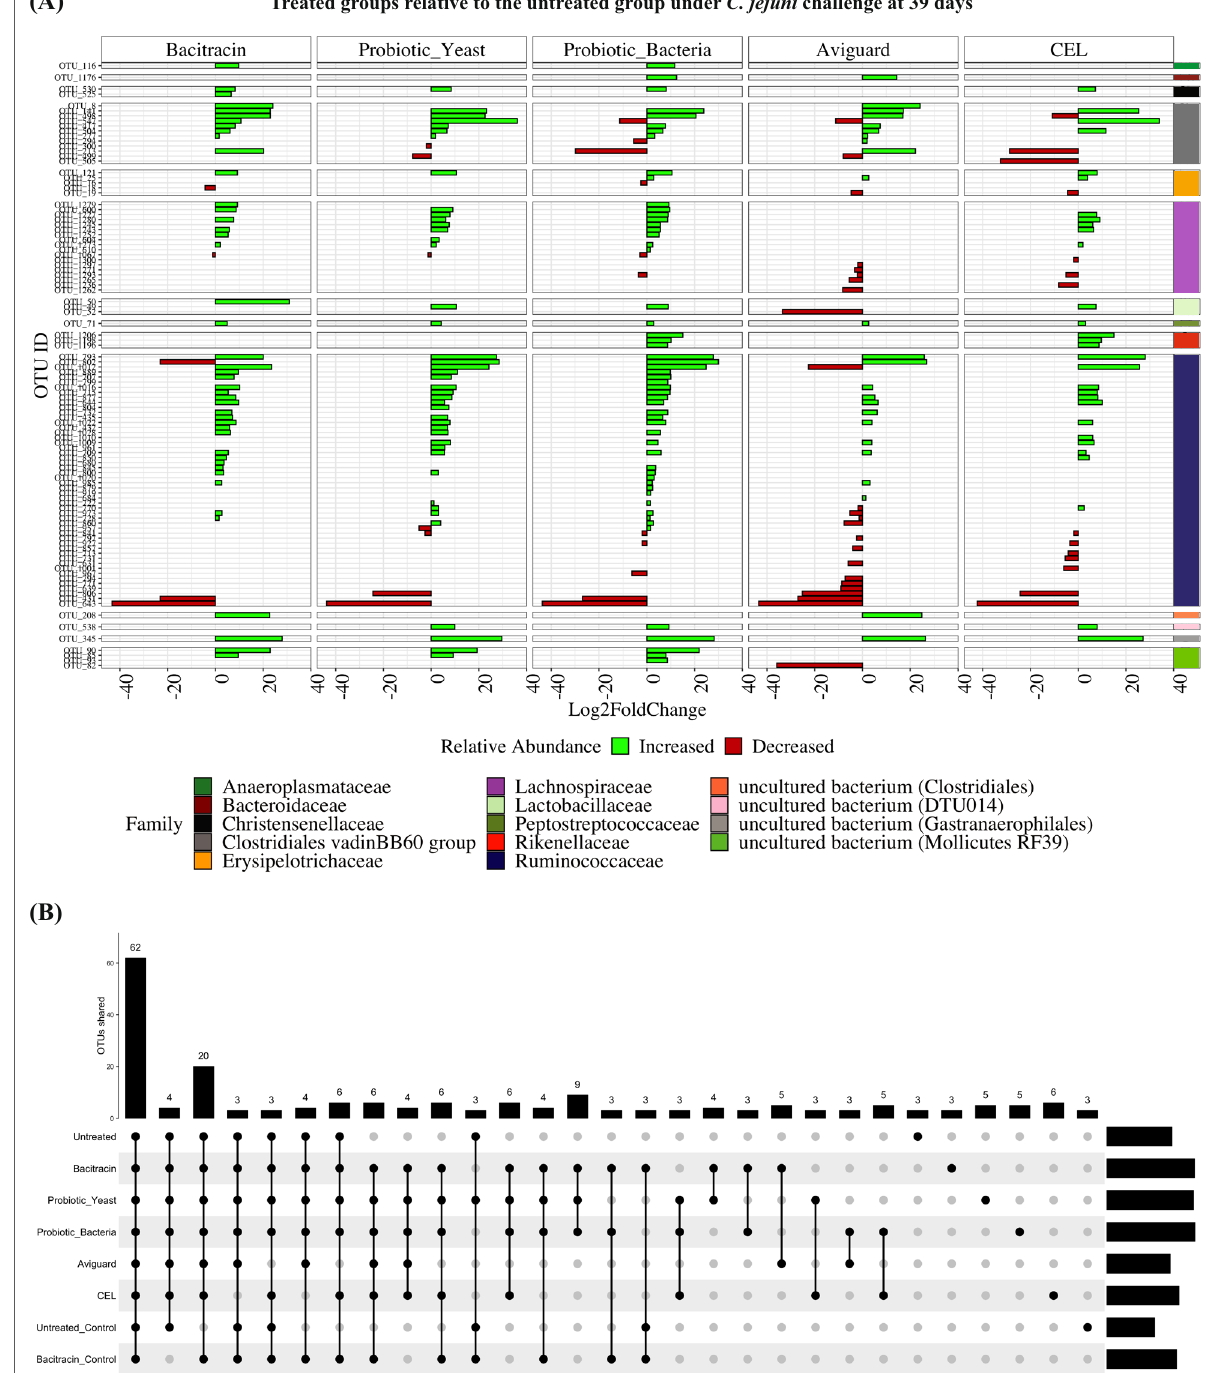
Fig. 4 Changes in abundance of OTUs across treatments. A Logarithmic fold changes of differential OTUs from differential abundance analyses with DESeq2 at 39 days post‑hatch, comparing treated groups to the untreated group under C. jejuni challenge. OTUs that are in significantly greater or lesser abundance are represented in green and red coloured bars respectively. OTUs are further grouped by their assigned taxonomic families. Legend lists taxonomic families in order of appearance B Vertical bars in the UpSet plot visualizes the number of OTUs unique to each treatment group and the number of OTUs shared between treatment groups at 39 days post‑hatch. Horizontal bars represent the total number of OTUs found in each treatment